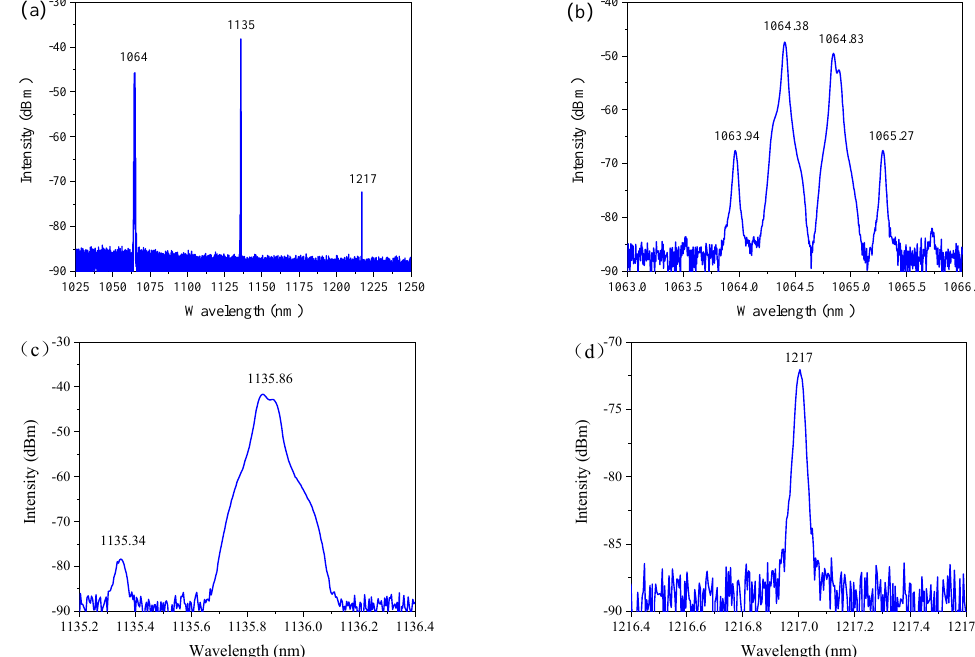
Figure 4. ( a ) The total output spectrum of 1 µ m all-fiber FGRL. ( b – d ) The fine spectrum of the residual pump laser, the first-order Stokes laser, and the second-order Stokes laser, respectively.